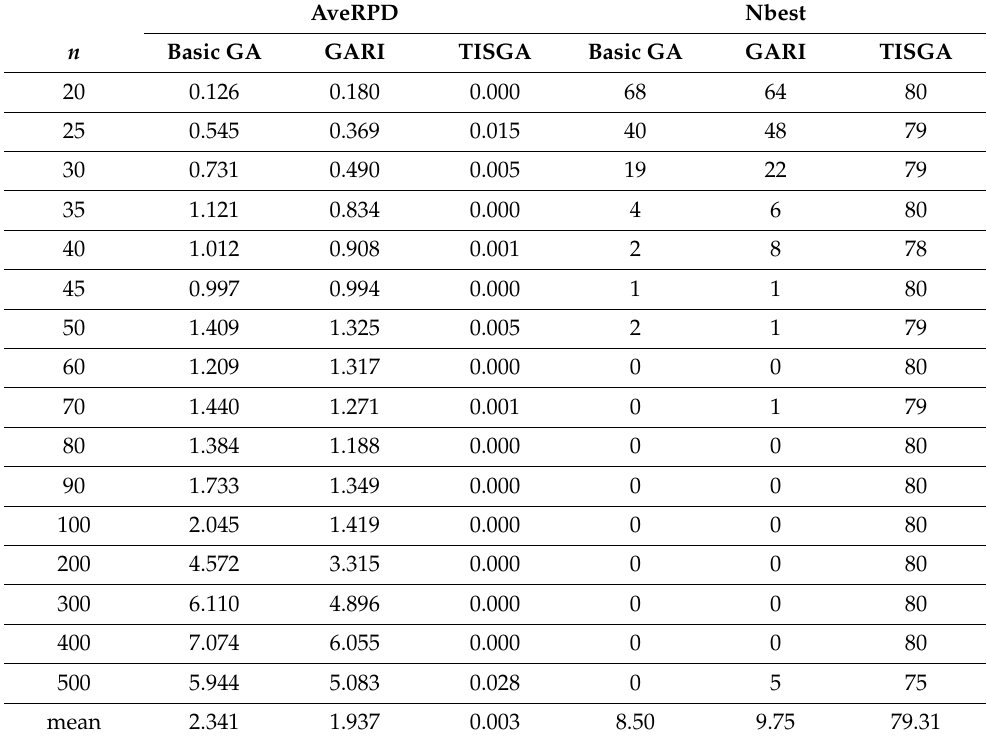
Table 10. Comparison of results for GAs for large-sized problems.